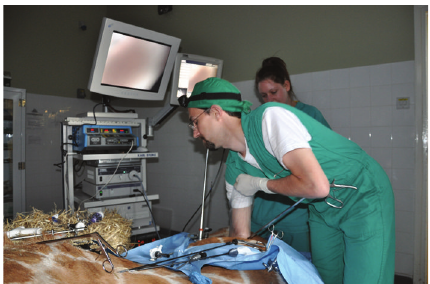
Figure 4: After laparoscopic exploration using standard 43cm length bariatric laparoscopic instruments, a port site was enlarged to allow hand and arm access in a full length glove, while still maintaining a